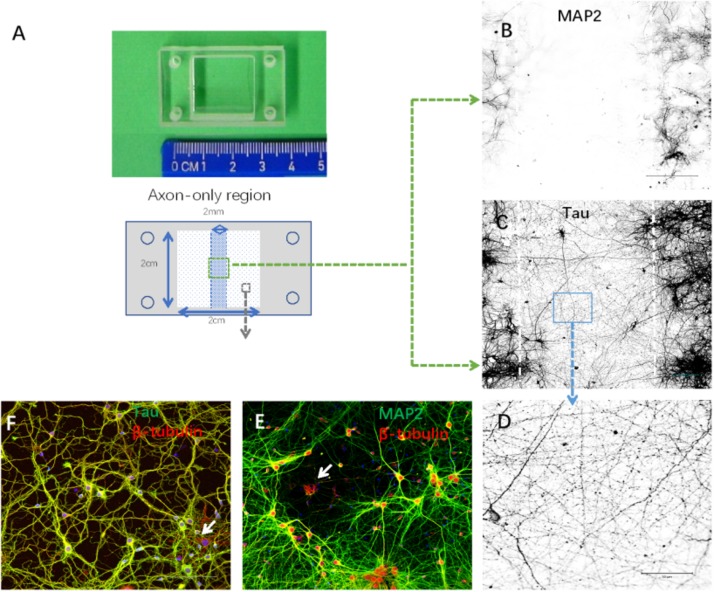
Establishment of cortical neuron cultures in a silicon chamber. (A) Silicon chamber (STREX) for primary neuron culture, upper. From the back view of the device, schematic illustration of the axon-only area (in the middle area with shadowing, 2 mm width × 2 cm length) and neuronal cell body region (white square area with spots) below. (B–D) Neurites in the axon-only area were axons confirmed by Tau-positive (C) but MAP2-negative (B) immunofluorescence. Representative image (D) of Tau immunostaining from the boxed area (C) shown under higher magnification. (E,F) Neurites in the somata region with positive immunoreactivity to either MAP2 (E) or Tau (F). Only a few non-neuronal cells [arrows in (E), β-tubulin-positive and MAP2-negative; arrows in (F), β-tubulin positive and Tau negative] were evident in the primary cortical neuron cultures. Scale bar = 100 μm.